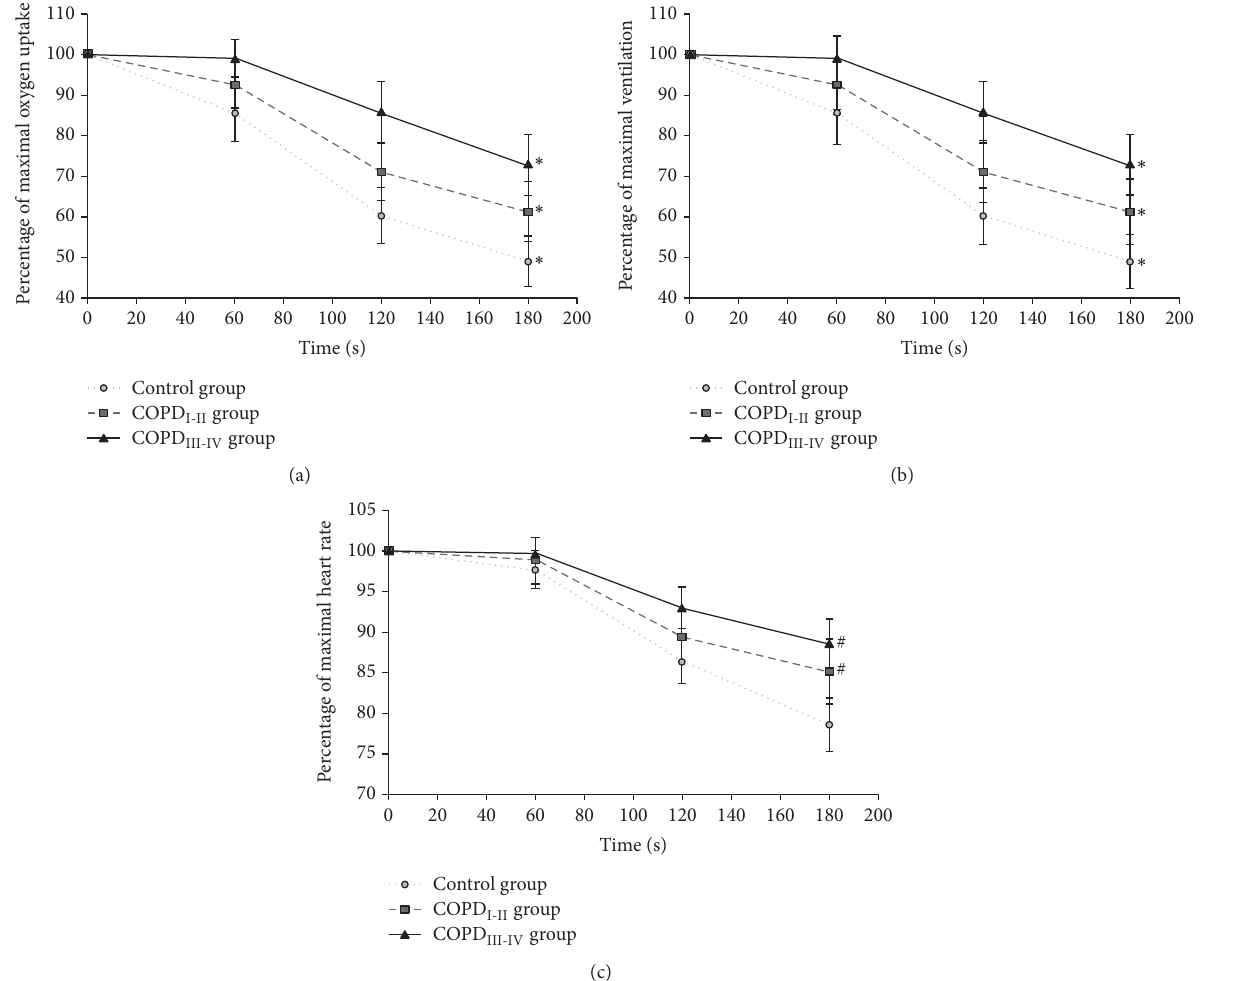
Figure 1: Kinetics of recovery of oxygen consumption (a), ventilation (b), and heart rate (c) according to groups. COPD: chronic obstructive pulmonary disease. ∗ Significantly different from both groups ( 𝑝 < 0.05 ). # Significantly different from control group ( 𝑝 < 0.05 ). COPD patients ( 𝑝 < 0.001 , 𝑟 = 0.53 ) and with peak power output ( 𝑝 < 0.001 , 𝑟 = 0.59